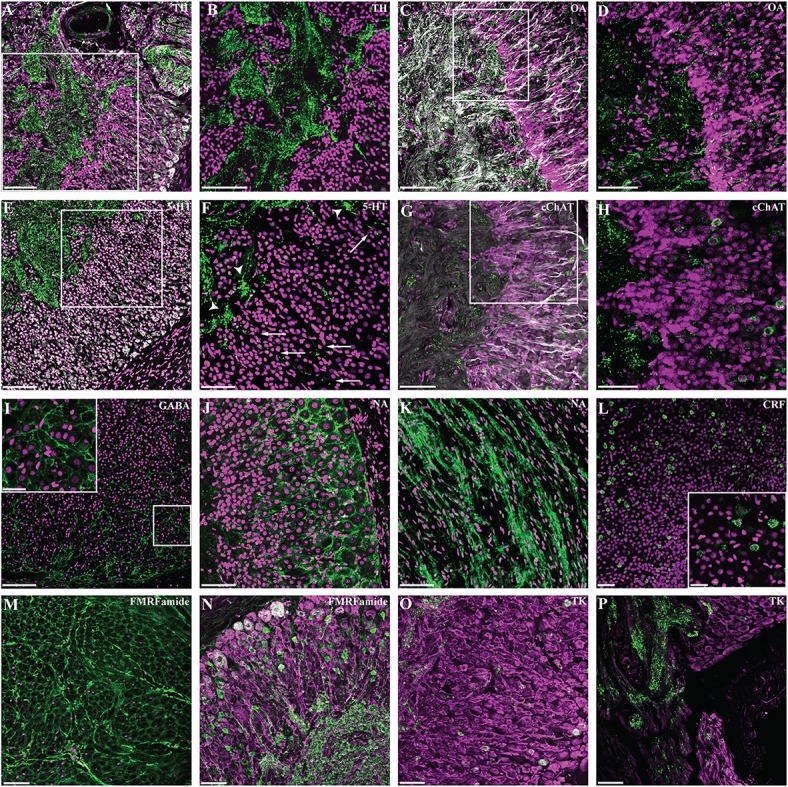
Neurochemical complexity of Octopus vulgaris gastric ganglion. Fluorescent immunoreactivity (in green) for: Tyrosine Hydroxylase (TH, A,B), Octopamine (OA, C,D), 5-hydroxytryptamine (5-HT, E,F), common Choline Acetyltransferase (cChAT, G, H), GABA (I), Noradrenaline (NA, J, K), Corticotrophin releasing factor (CRF, L), FMRF-amide (M,N), and Tachykinin (TK, O,P); DAPI is utilized as nuclear stain (magenta, except in N–P). Co-localization with acetylated alpha-tubulin (AcTub) is shown in (A,E,N,O,P) with neurofilament (NF) in (C,G). TH-IR fibers as they appear in the internal neuropil of the gastric ganglion (A) co-localized with AcTub (gray). The white square area in (A) is enlarged in (B) to show the strong TH immunoreactivity at the level of neural processes. (C) The intricate network of octopamine positive fibers and button-like positivity as seen in the neuropil and cellular layer (colocalized with NF, gray). The high magnification in (D) shows details of octopamine-IR fibers inside the cellular layer and their prolongation within the internal neuropil. (E) 5-HT-IR and AcTub (gray) revealed fibers in the internal neuropil with several processes progressing toward the cellular layer. The high magnification detail in (F) shows some of these processes in the cellular layer (arrows), and some clustered network fibers (arrowheads). (G) The common Choline Acetyltransferase immunoreactivity seen in cells and fibers, co-localized with NF (gray). The magnification in (H) to highlight cChAT-IR in cells. GABA-IR (I) identified an intricate network surrounding the cells of the cortical layer; a magnification is provided in the enlargement. (J) Noradrenaline immunoreactivity revealing an intricate reticulum surrounding cells of cellular layer, and at the level of the sympathetic nerve (K). CRF-IR positive cells (L) and detail in the higher magnification (square) of the cellular layer. FMRFamide-IR fibers are observed in the intestinal nerve (transverse section, M). FMRFamide-IR fibers in the neuropil of the gastric ganglion (N) with processes and cells in the cellular layer (co-localized with AcTub, magenta). Tachykinin-like IR in cells and fibers in the neuropil (O,P); co-localization with AcTub (magenta). See text for details. Scale bars: 100 μm (A,B,D,E,H,I,J,K,L); 50 μm (C,G,F,M,N,O,P); 25 μm (higher magnification in L,I).